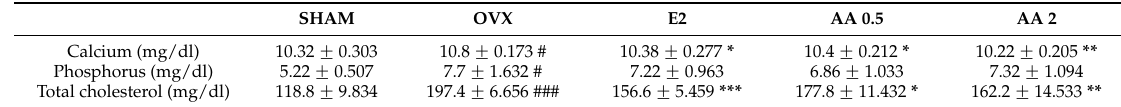
Table 2. Effect of AA on serum biochemical markers.